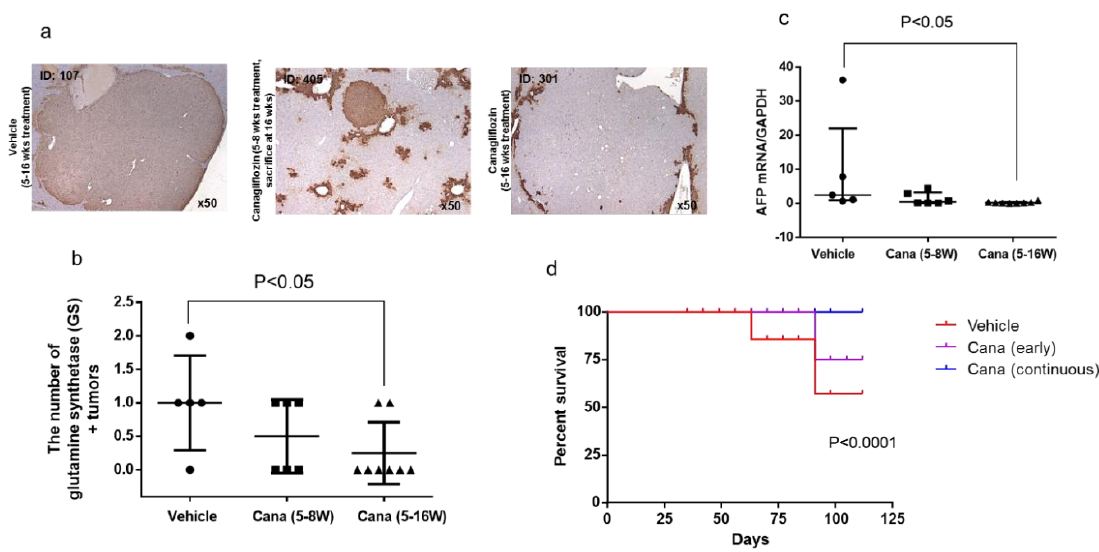
Figure 5. Canagliflozin inhibited progression of hepatic carcinogenesis from NASH. ( a,b ) Representative microphotographs of immunohistochemical staining for glutamine synthetase (GS) in liver sections and percentage in area of positive immunostaining for GS in the three groups. ( c ) mRNA expression of α -fetoprotein in the liver of the three groups. ( d ) Survival curves of STAM mice treated with the three treatments.